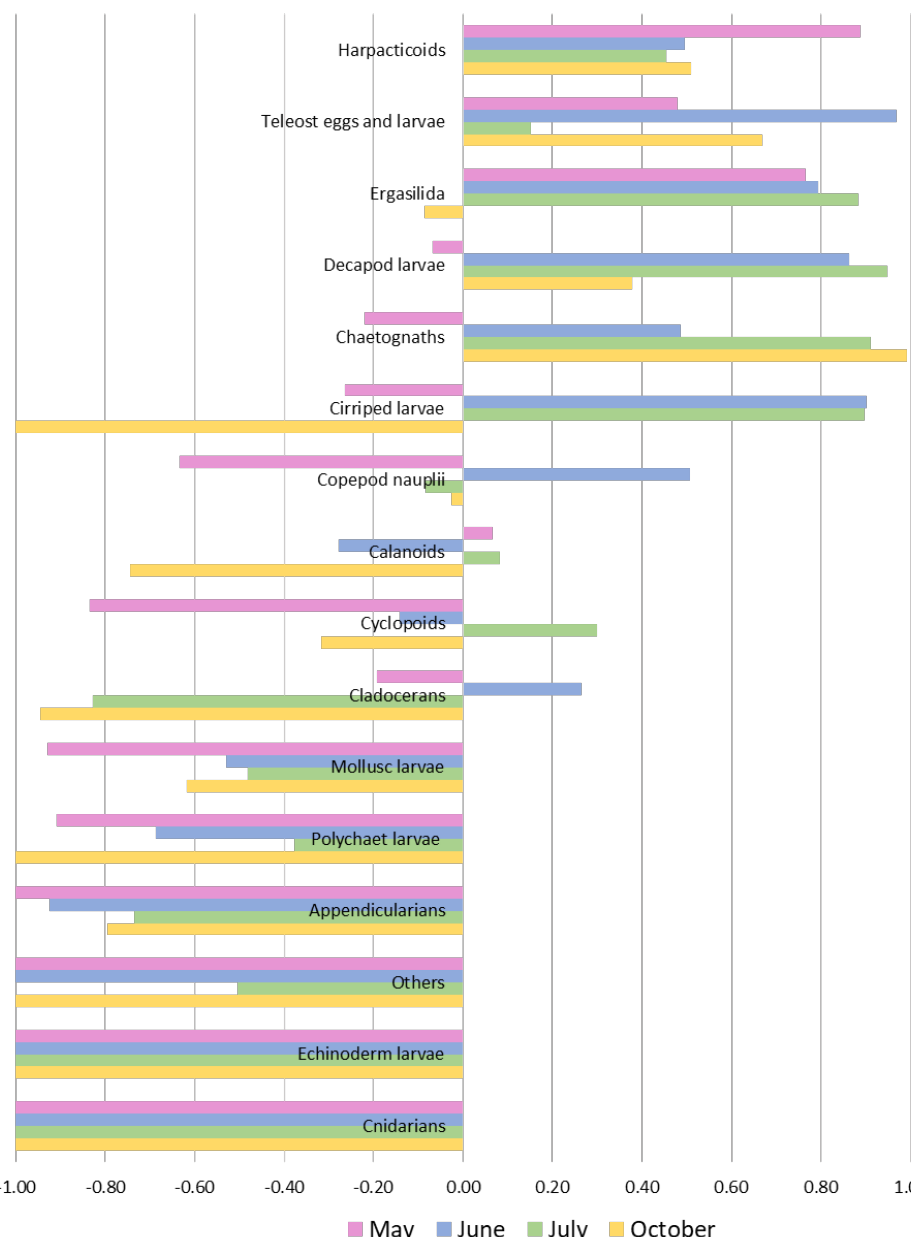
Figure 5. Distribution of small prey (<2 mm size) in gut contents: mean counted prey/stomach by size classes of 50 µm (histograms) and their relative carbon content (red solid line) in ( a ) May, ( b ) June, ( c ) July and ( d ) October.